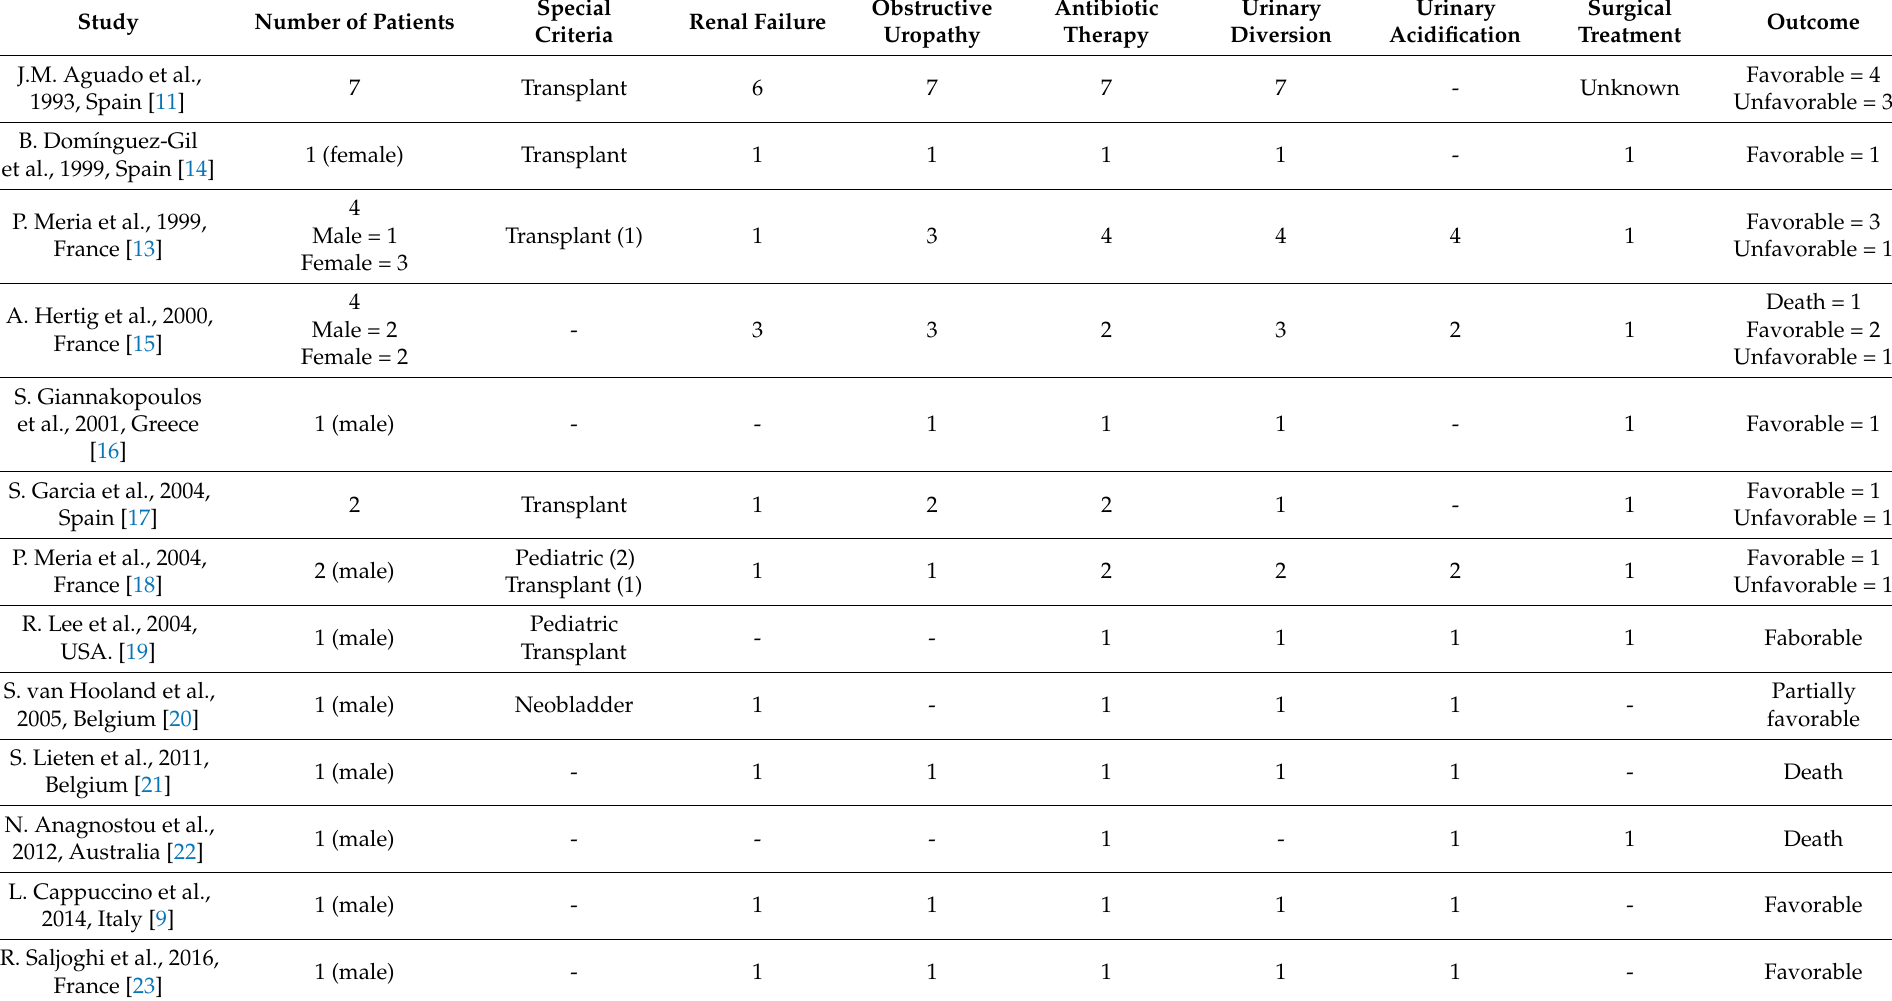
Table 1. Published cases of encrusted uretero-pyelitis caused by Corynebacterium urealyticum